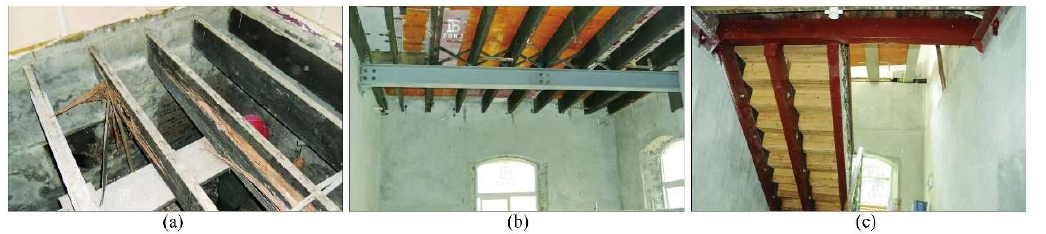
24 of 29 Figure 20. Wall strengthening (source: author). ( a ) Damaged exterior walls ( b ) Strengthening in progress ( c ) Wall strengthening methods A pressure pump was used to inject a cement slurry to seal the cracks in the wall. The broken brick walls were repaired to ensure wall integrity and improve the load-bearing capacity. Clay bricks adopt different repair methods according to the damage depth; when the damage depth of the brick is less than 10 mm, it will not be repaired, but only cleaned and protected. When the damage depth of the brick is 10–20 mm, it should be repaired with brick powder. The brick powder material has good compatibility with the original wall, and the color is similar to the original wall. After adding water and mixing well, an appropriate amount of adhesive was added, the damaged part of the wall was repaired, and then the mortar joints were filled. When the damage depth of the brick is greater than 20 mm, the damaged surface will be cleaned and repaired with brick bat. The strengthened wall adopts the steel mesh and polymer mortar surface layer, which not only improves the bearing capacity and earthquake resistance but also mini- mizes the impact on the use of indoor space. A total of 40 mm of thick steel mesh and polymer mortar were added to the inside of the exterior wall for strengthening; 40 mm of thick steel mesh and polymer mortar were added to both sides of the interior wall for strengthening. The strengthening method is shown in Figure 20c.